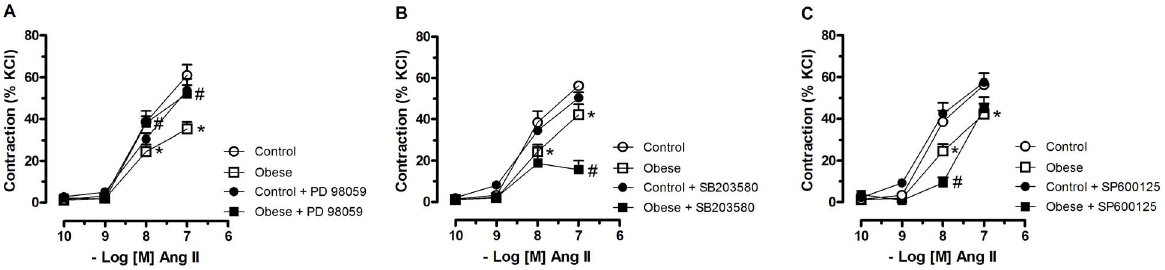
Figure 4. Involvement of MAPKs on angiotensin II-induced contraction. Mesenteric arteries with intact endothelium from control and monosodium glutamate-induced obese rats were pretreated with PD 98059 (1 m M), a specific MEK/ERK1/2 inhibitor ( A ), SB-203580 (1 m M), a catalytic inhibitor for p38 MAPK ( B ), or SP 600125 (1 m M), an inhibitor of JNK ( C ) for 30 min and non-cumulative concentration–response curves to angiotensin II (ANG II) were obtained. Each point represents the mean 6 SEM. *, P , 0.05 vs. Control. # , P , 0.05 vs. respective group in the absence of blockade.